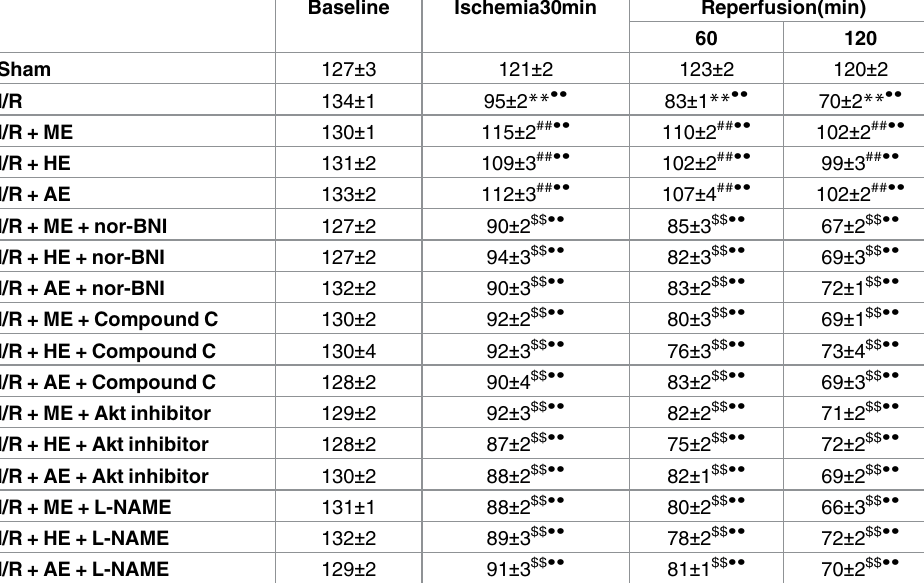
Table 2. Changes in LVP (mmHg) during myocardial